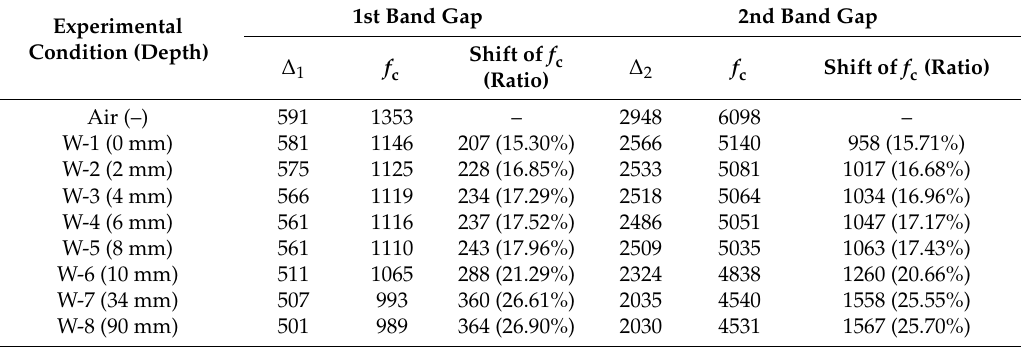
Table 3. Widths of the band gaps, center frequencies, and percentage of shift of the center frequency in the displacement transmission of the PC beam operated in different experimental conditions.